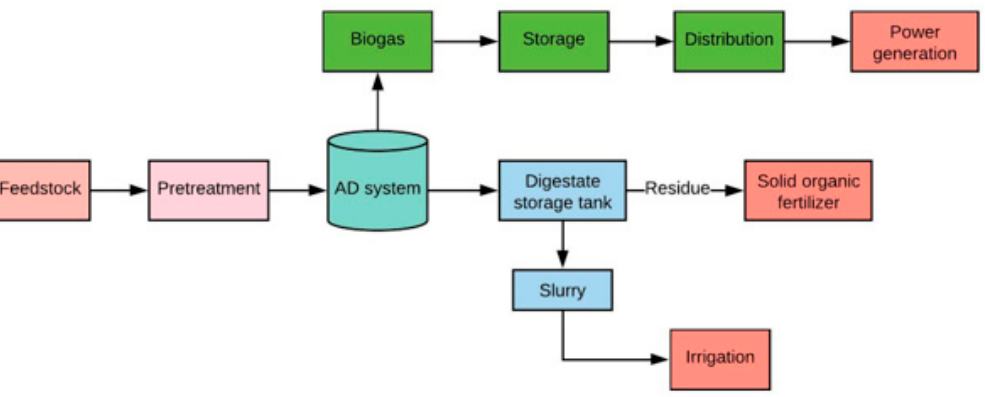
Figure 2. General process flowchart of a biogas plant (Liu et al.,